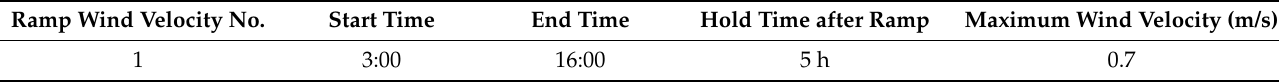
Table A4. Parameters of the ramp wind velocity in Scenario I in the case